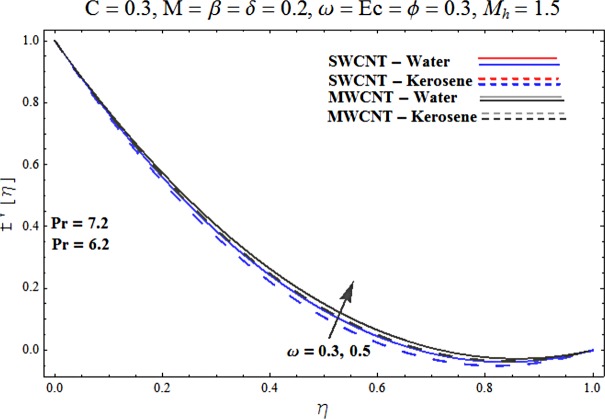
Effect of ω on f′.